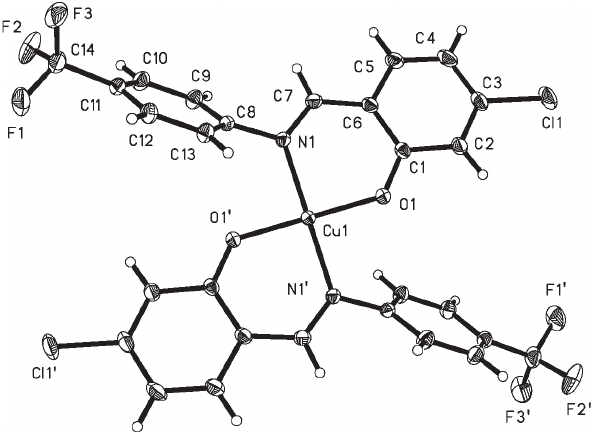
Table 2: Fractional atomic coordinates and isotropic or equivalent isotropic displacement parameters (Å 2